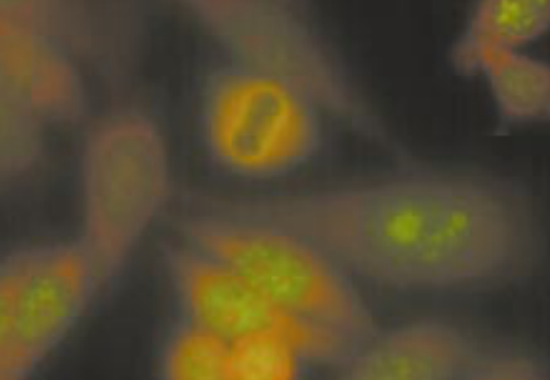
Figura 1 – Árvore de decisão